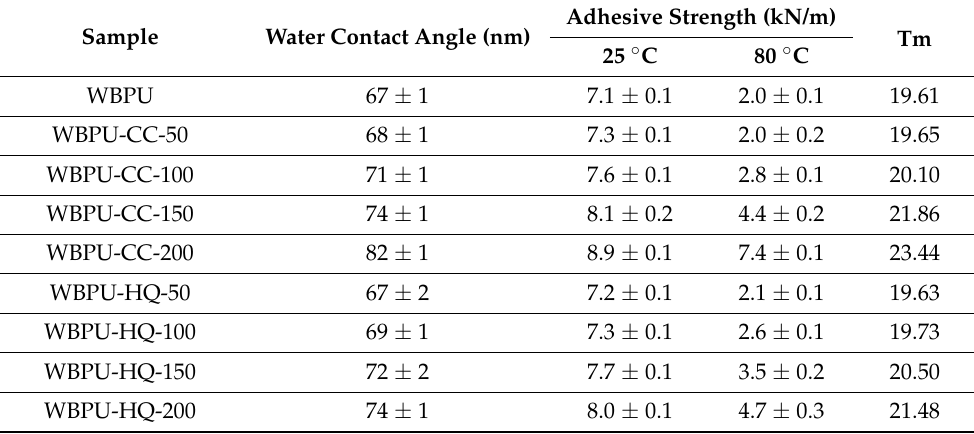
Figure 6. UV-vis spectra of isolated WBPU and WBPU-X complexes calculated at B3LYP/6-31 + G (d, p) level of theory. In the figure, solid, dashed, and dotted lines represent the UV-vis spectra of isolated WBPU, WBPU-catechol, and WBPU-Hydroquinone complexes, respectively. Table 3. The properties of WBPU